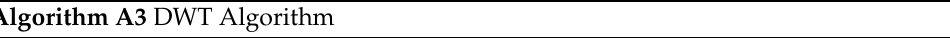
Algorithm A3 DWT